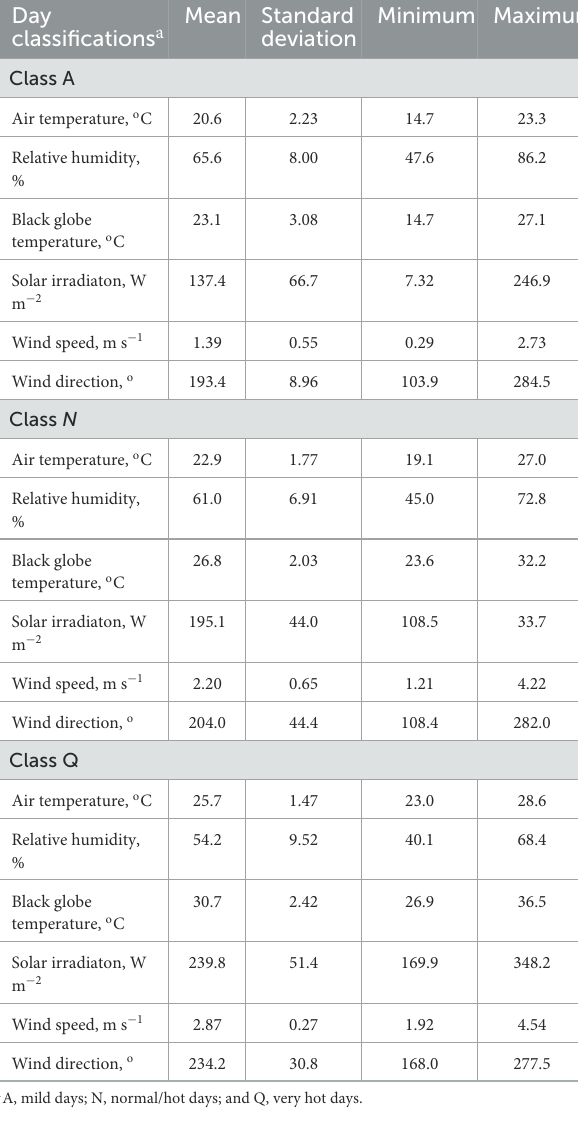
TABLE 4 Fatty acid profile of longissimus muscle of Bos indicus -influenced feedlot cattle supplement with lysolecithin-derived feed additive in Experiment 2.